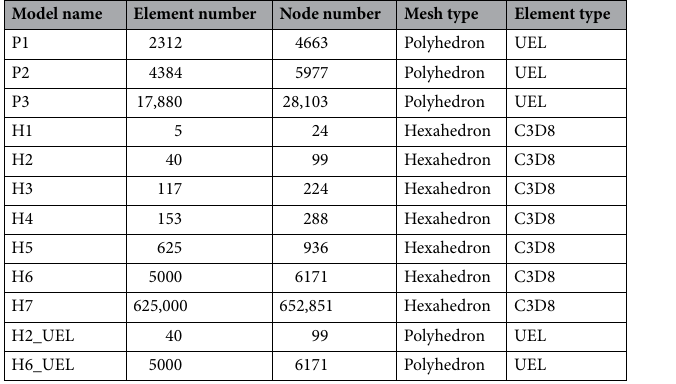
Table 4. Mesh information of the